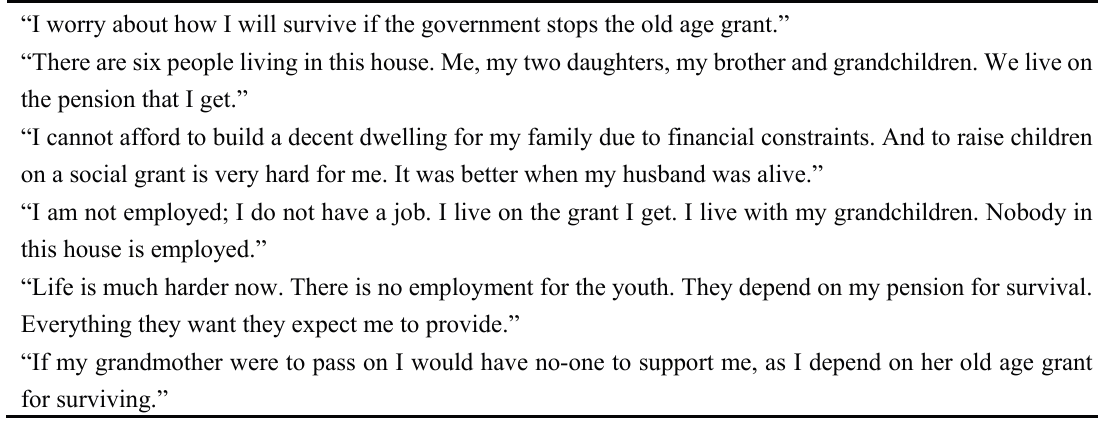
Table 4. Narratives from life histories indicating dependency on social welfare grants (n =